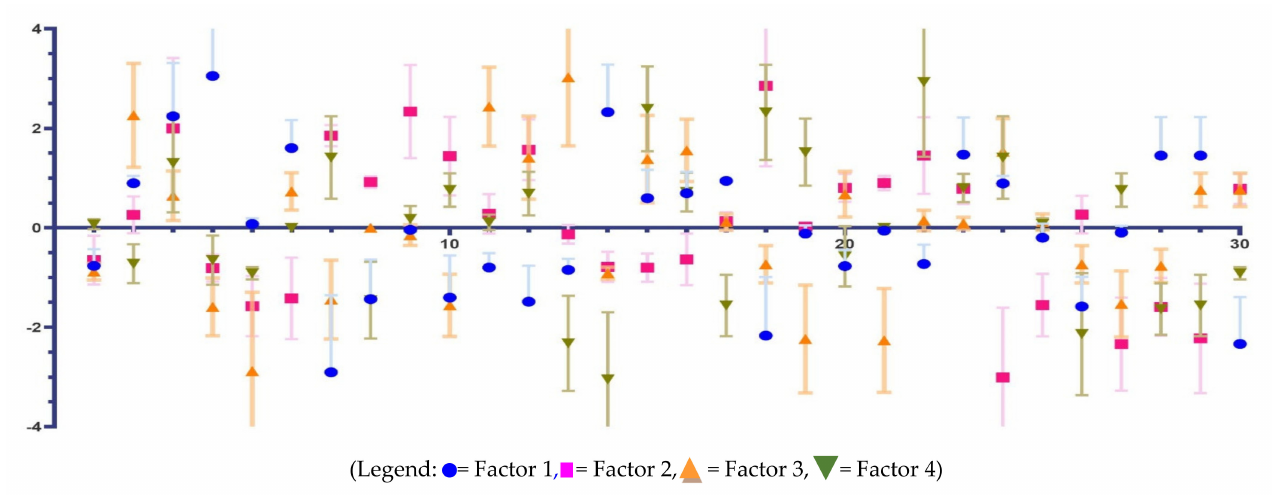
Figure 7. The Z-scores of each